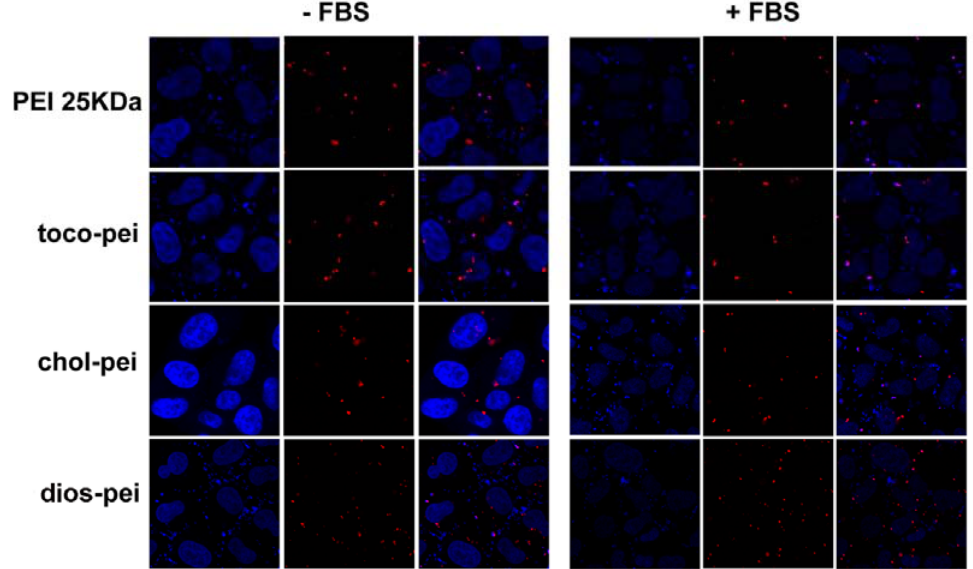
Figure 12. Confocal images toward HeLa cells: lipopolymer/Cy5-labeled DNA polyplexes at optimal transfection w / w ratios for 4 h; ( left ) serum-free medium; ( right ) 10%-serum-containing medium, 25-kDa PEI was used as a control. For each triplicate image, from left to right: cell nuclei stained by 4 ′ ,6-diamidino-2-phenylindole (DAPI; blue); Cy5-labeled pDNA (red); merged image.